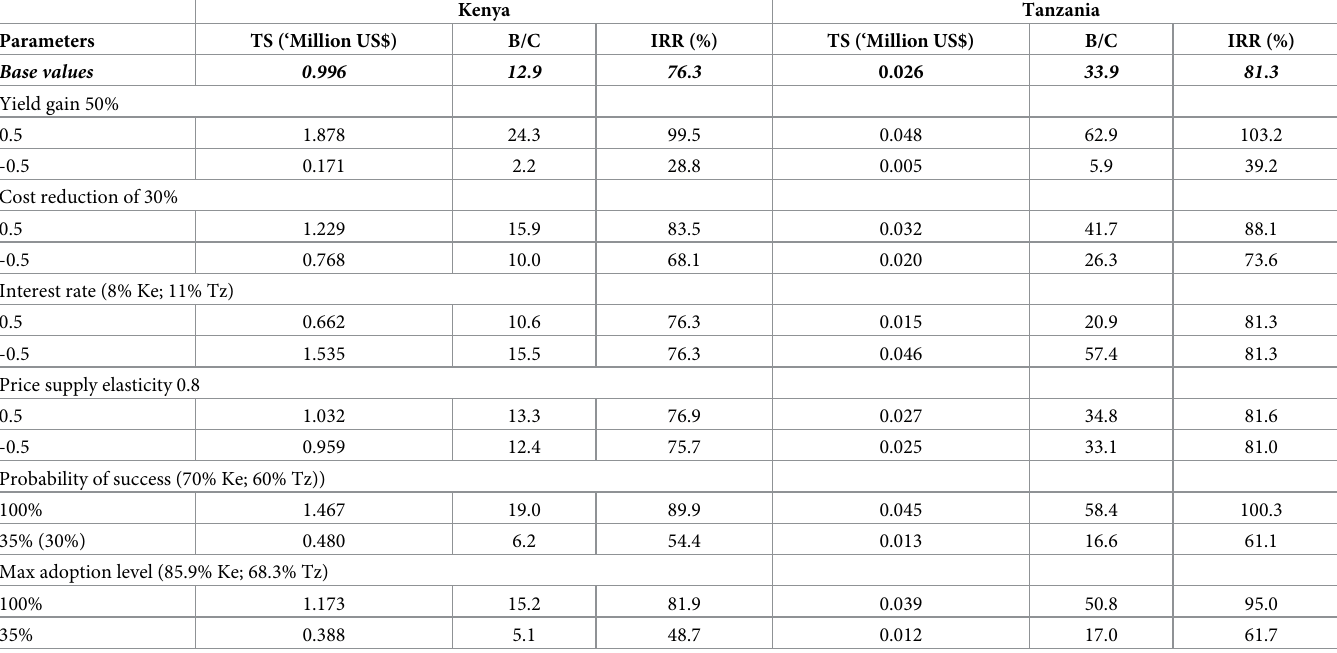
Table 5. Sensitivity analysis of key parameters for the economic surplus model. Kenya